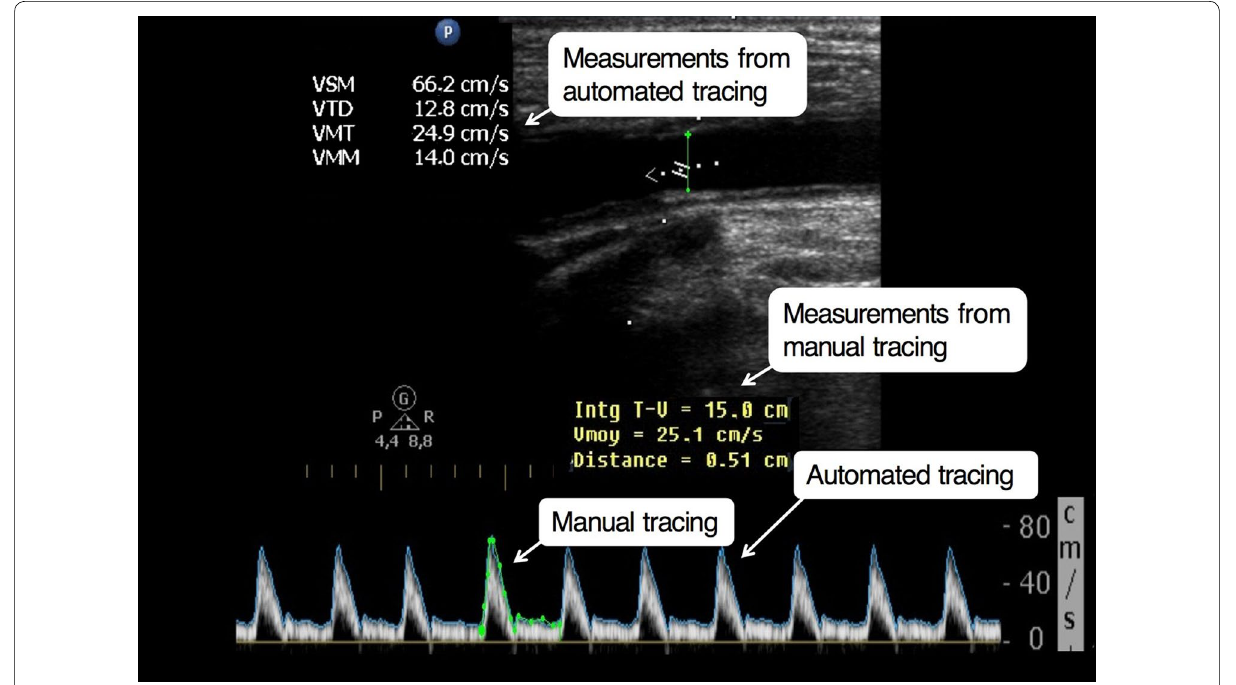
Fig. 1 Example of Doppler measurements performed in a